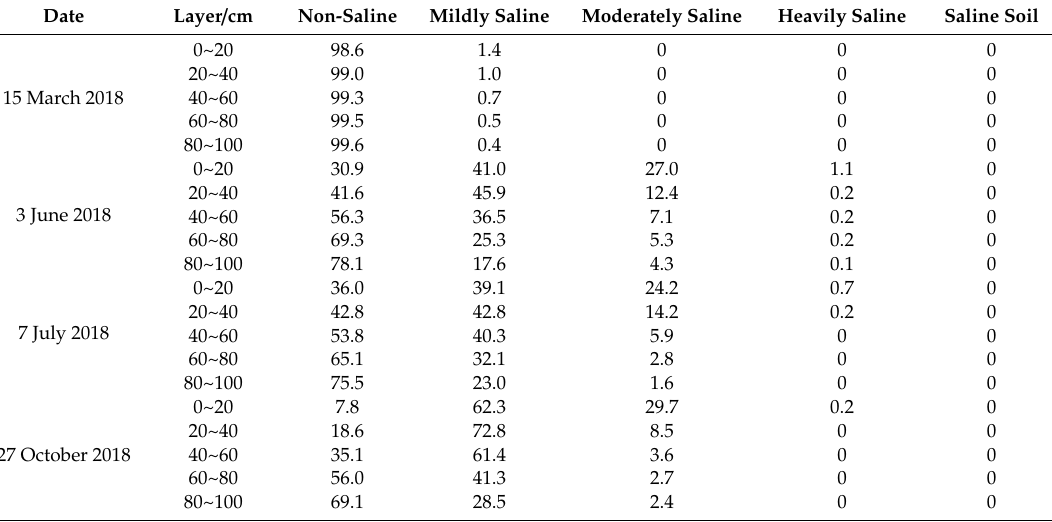
Table 5. Proportion of soil salinization grades in di ff erent periods of the test